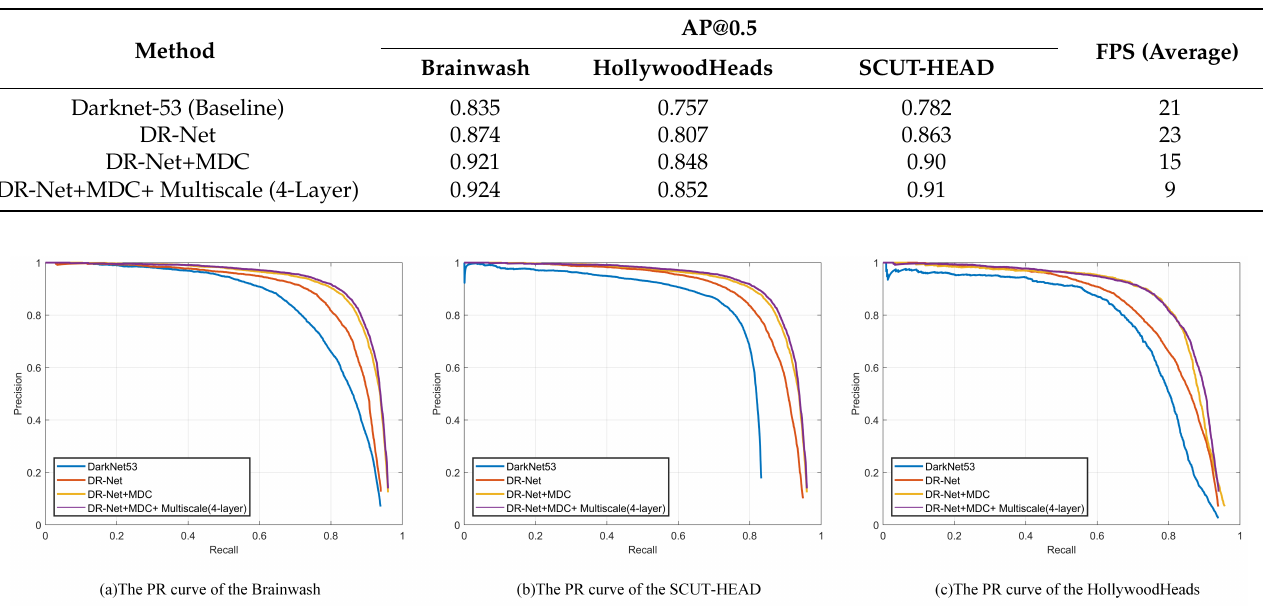
Table 5. Comparison of the ablation experiment results on three datasets.